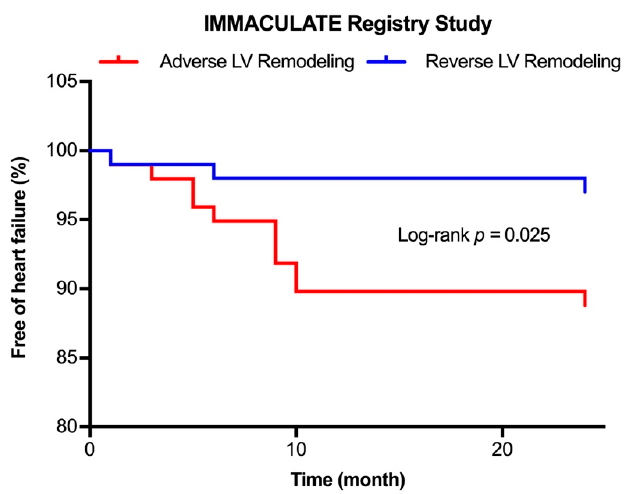
Figure 4. Incidence of heart failure during follow-up. Kaplan–Meier analysis for rehospitalization due to heart failure stratified by post-AMI LV remodeling.